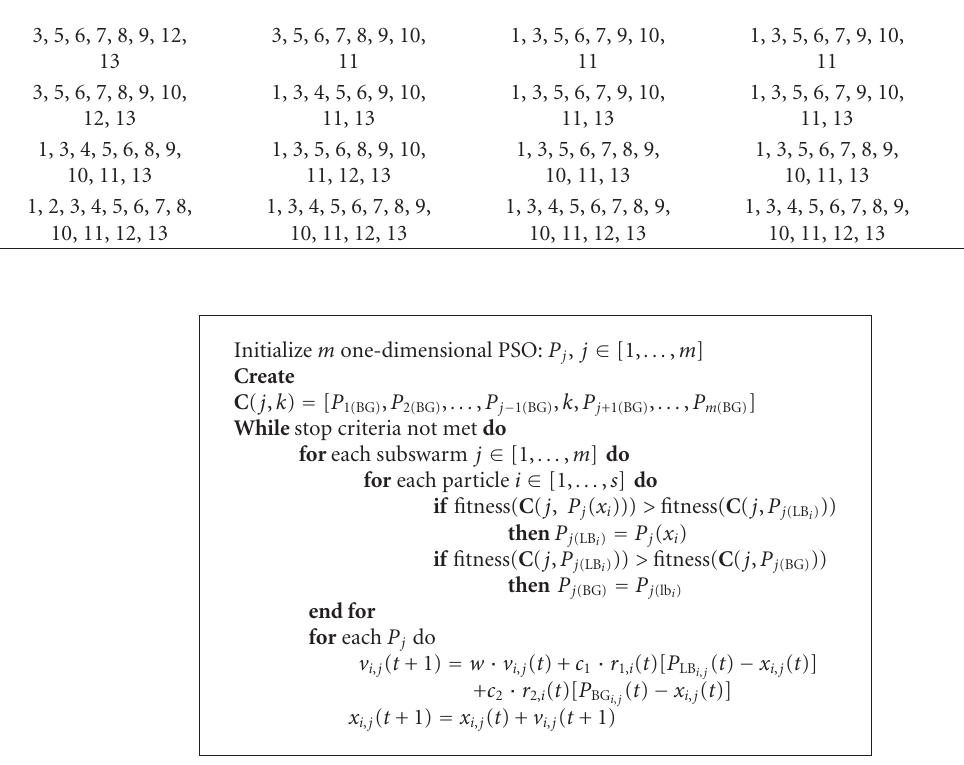
Algorithm 1: Pseudocode for cooperative